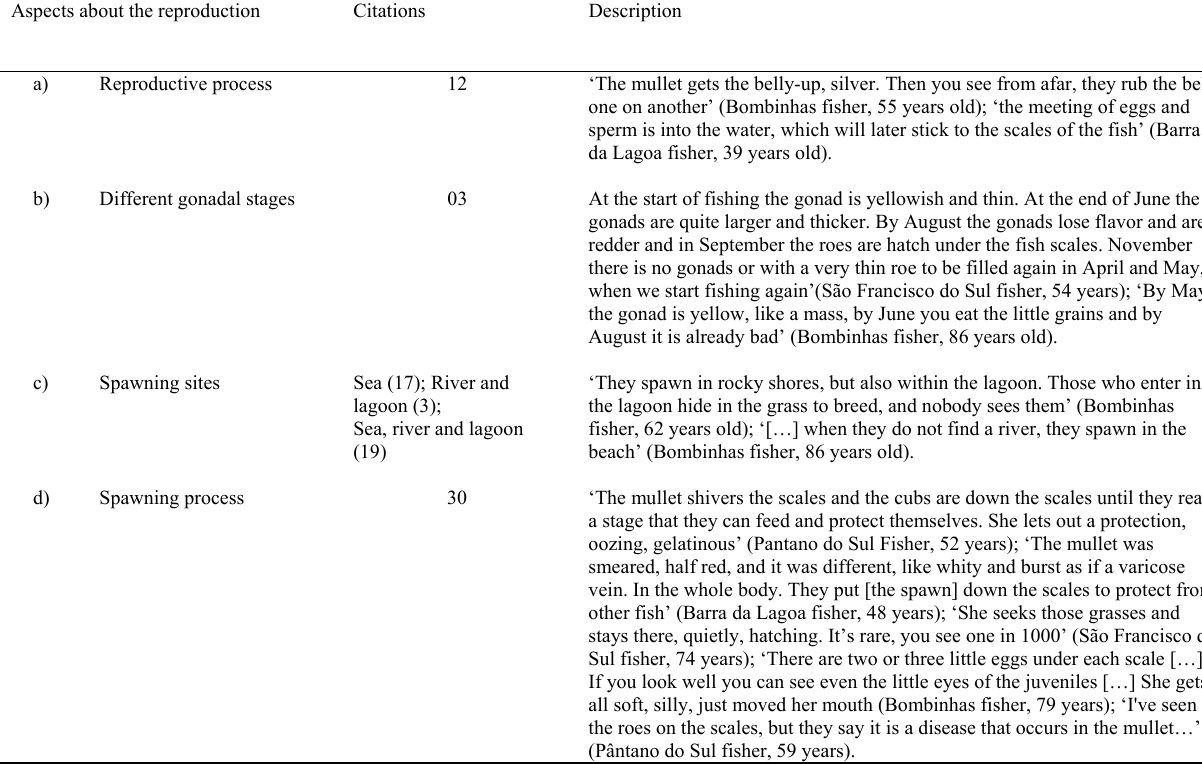
Table 4. Descriptions of 45 fishers of Santa Catarina State about the reproductive aspects of mullet ( Mugil liza ). Aspects about the reproduction